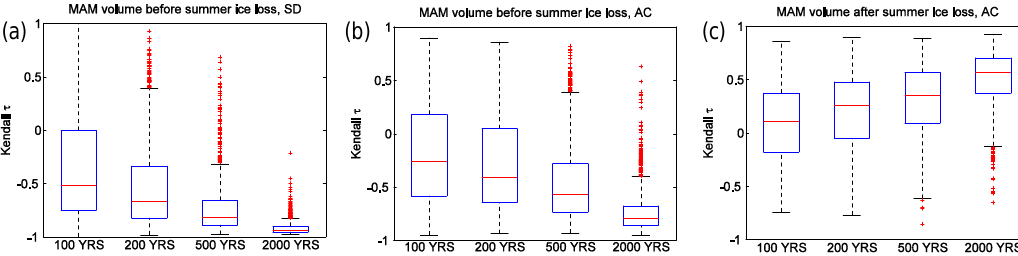
Figure 7. Statistics of Kendall’s tau for standard deviation (SD) and autocorrelation (AC) changes in ensemble simulations with the E07 model. Each figure shows results for MAM time series of sea-ice volume. The number of years refers to the total length of an experiment until CO 2 has quadrupled. (a) Standard deviation trends before summer sea-ice loss; (b) autocorrelation trends before summer sea-ice loss (perennial ice regime); (c) autocorrelation trends in the period between summer sea-ice loss and winter sea-ice loss (seasonal ice regime). On each box, the central mark is the median, the edges of the box are the 25th and 75th percentiles, the whiskers extend to the most extreme data points not considered outliers, and outliers are plotted